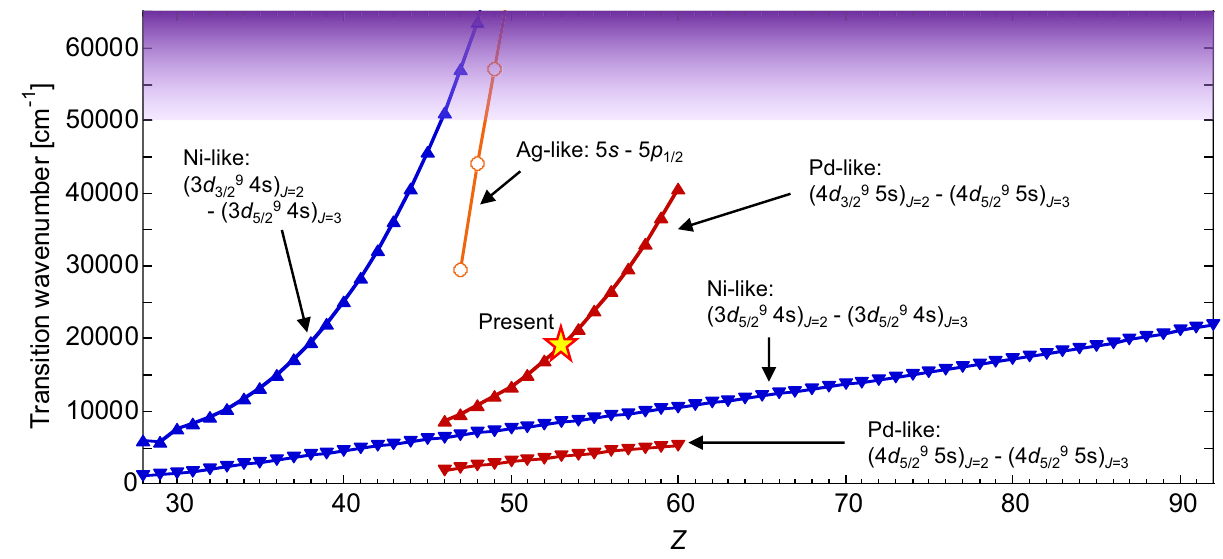
Fig. 5 Potential of the present laser spectroscopy for studying heavy nuclei. Atomic number ( Z ) dependence of the theoretical transition energies in Pd- like (red) and Ni-like (blue) ions, along with the transition energies of the E 1 transition 5 s – 5 p 1/2 in Ag-like ions (orange) for comparison. The present transition (4 d 9 5 s ) J = 2 - (4 d 9 5 s ) J = 3 in 127 I 7 + is highlighted by the star symbol. The purple-shaded region indicates wavelength ranges where it is 3 = 2 5 = 2 generally dif fi cult for lasers to reach (<200